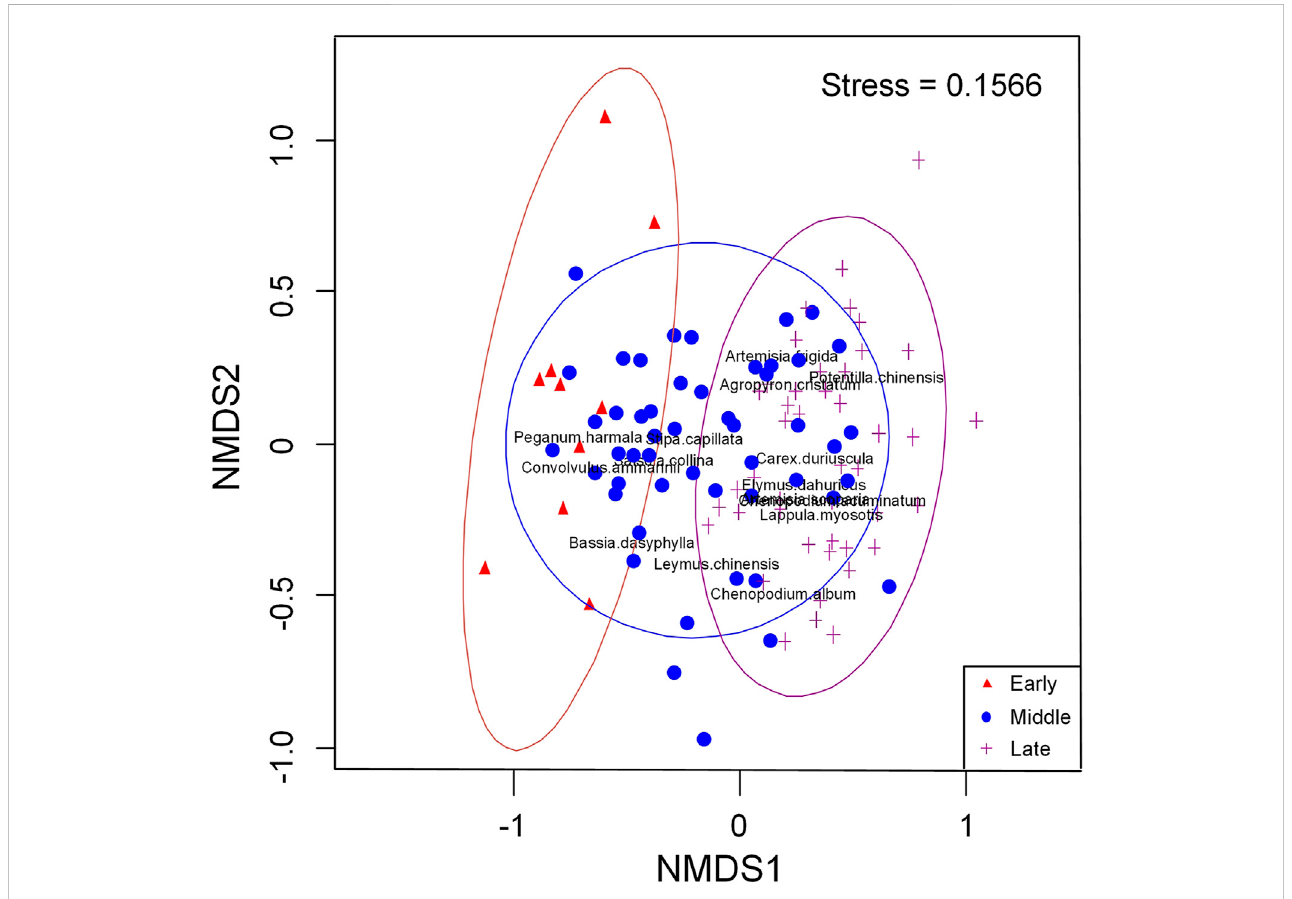
FIGURE 3 Species distribution of three stages of restoration through non-metric multidimensional scaling